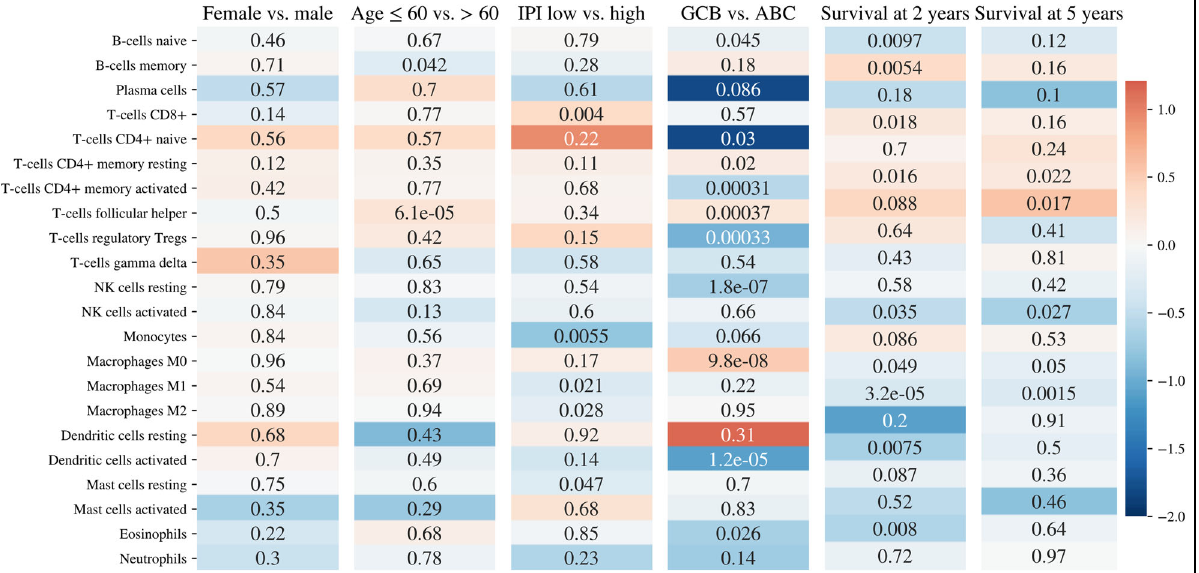
Fig. 2 Clinically Strati fi ed Immune Cell Type Assessment. Heatmaps showing the differential assessment of the immune contexture within clinical risk